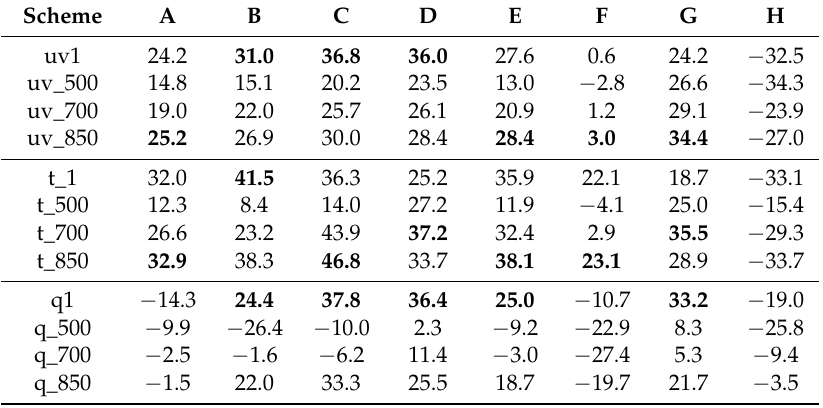
Table 4. RATE (%) of simulated near-surface meteorological elements with different nudged levels.